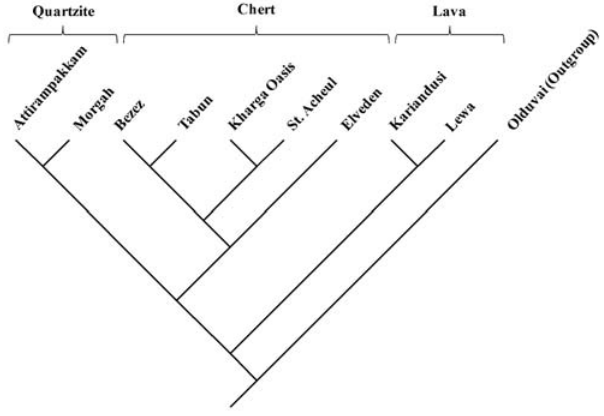
Figure 3. Raw material model tree.